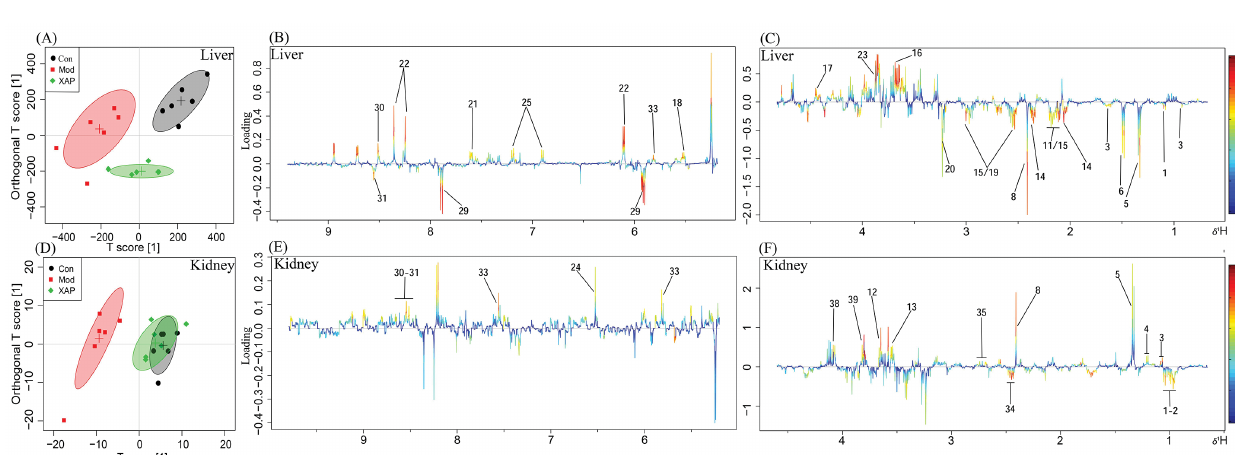
FIGURE 1 - OPLS-DA analysis of liver and kidney extract 1 H NMR data of control, model, and MTE groups. Score plots (A for liver, D for kidney) and the corresponding loading plots of OPLS-DA (B and C for liver, E, and F for kidney) color-coded with the absolute value of correlation coefficients. The color bar corresponds to the weight of the corresponding variable in the discrimination of statistically significant (red) or non-significant (blue).Positive and negative peaks indicate a relatively decreased and increased metabolite level.